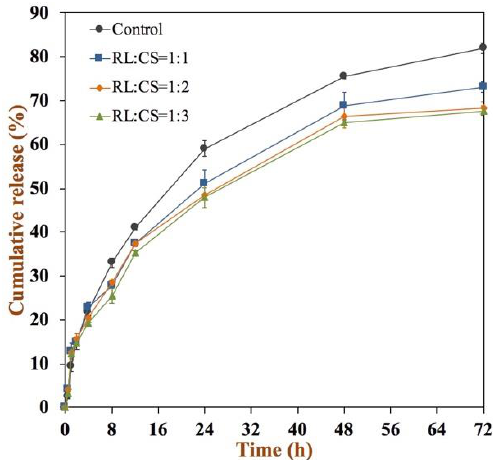
Figure 6. In vitro release curves of curcumin in Cur-loaded liposomes with different ratios of RL/CS at 37 C for 72 h.